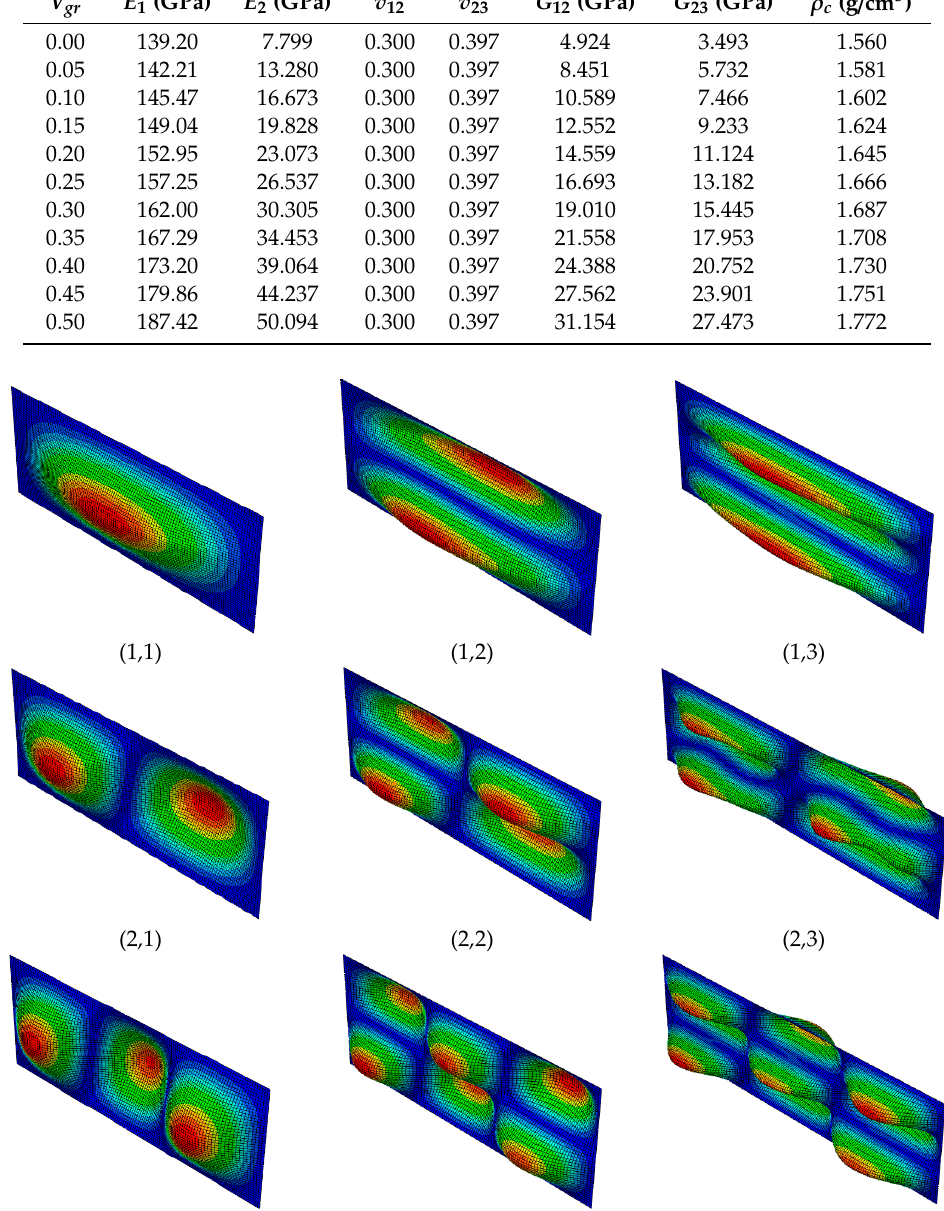
Figure 2. Mode shapes of vibration of a composite plate with w = 25 mm, l = 64 mm, and CCCC boundary conditions.